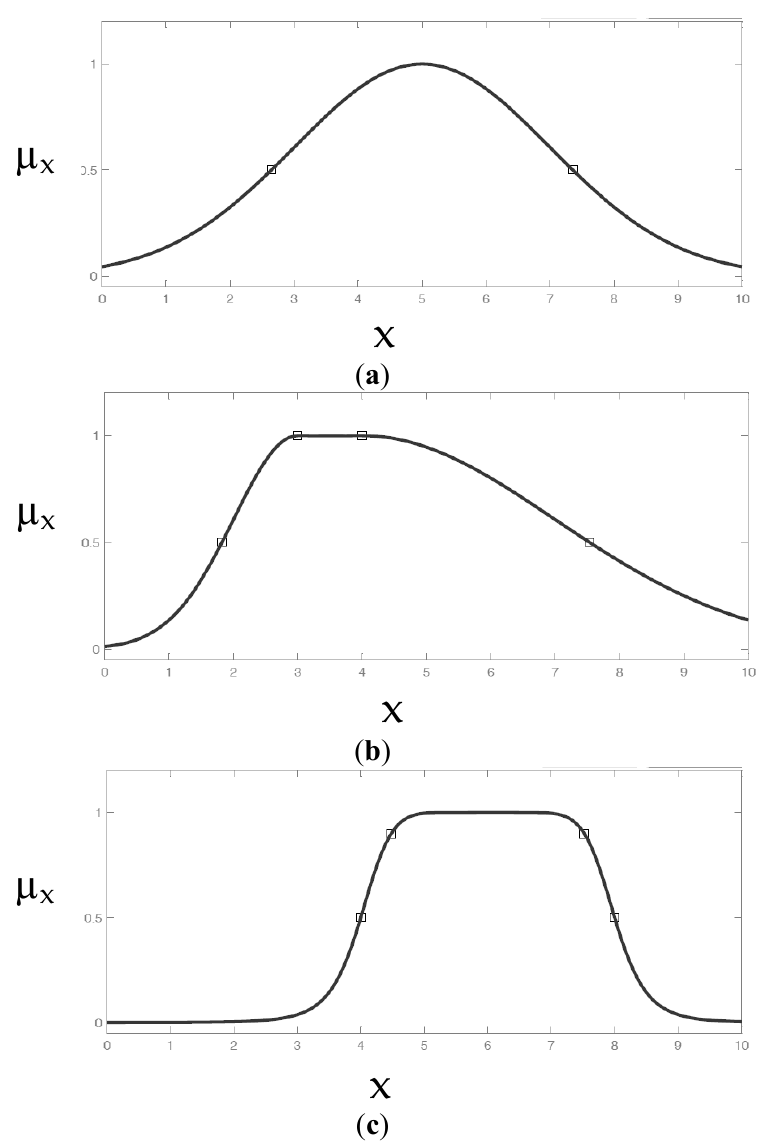
Figure 7. ( a ) Gauss membership function; ( b ) Gauss2 membership function; ( c ) Generalized bell (Gbell) membership